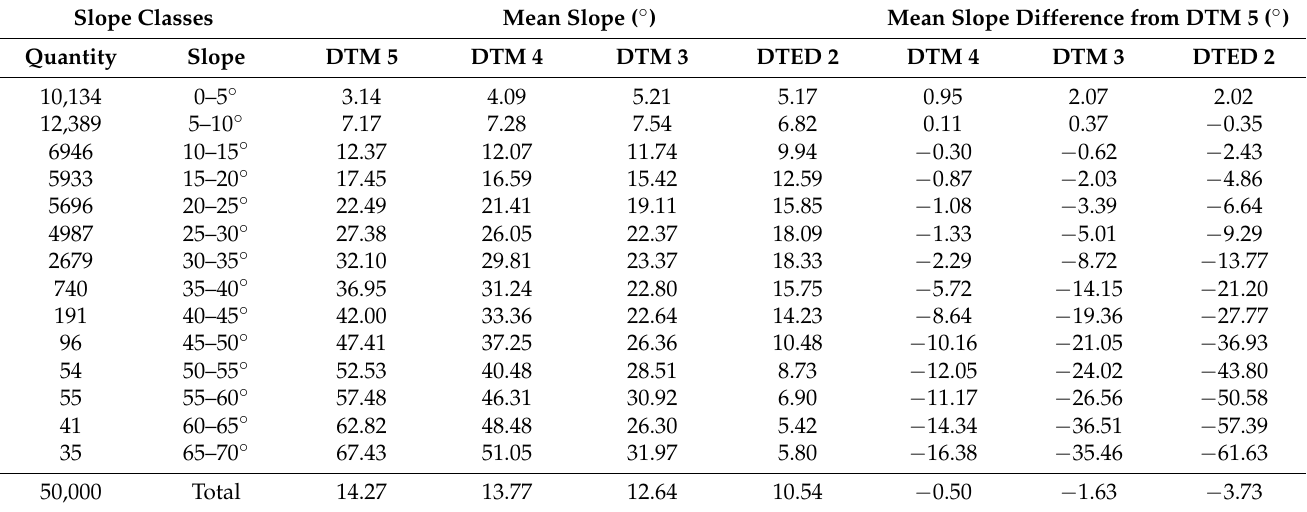
Table 3. A comparison of slopes in random points generated from elevation models and their statistics. Mean Slope ( ◦